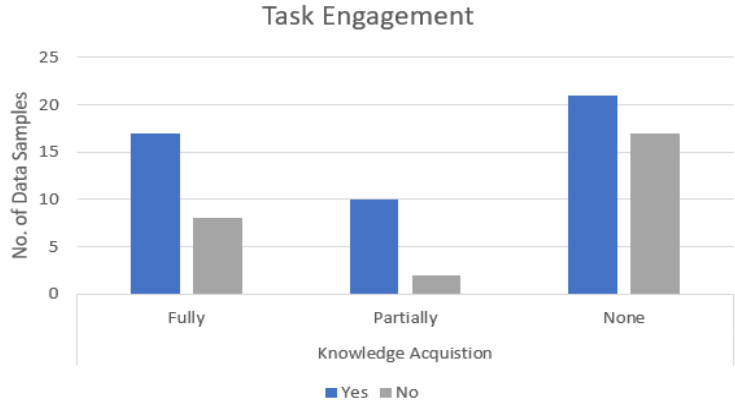
Figure 11. Graph representing engagement in task for learners in different KA